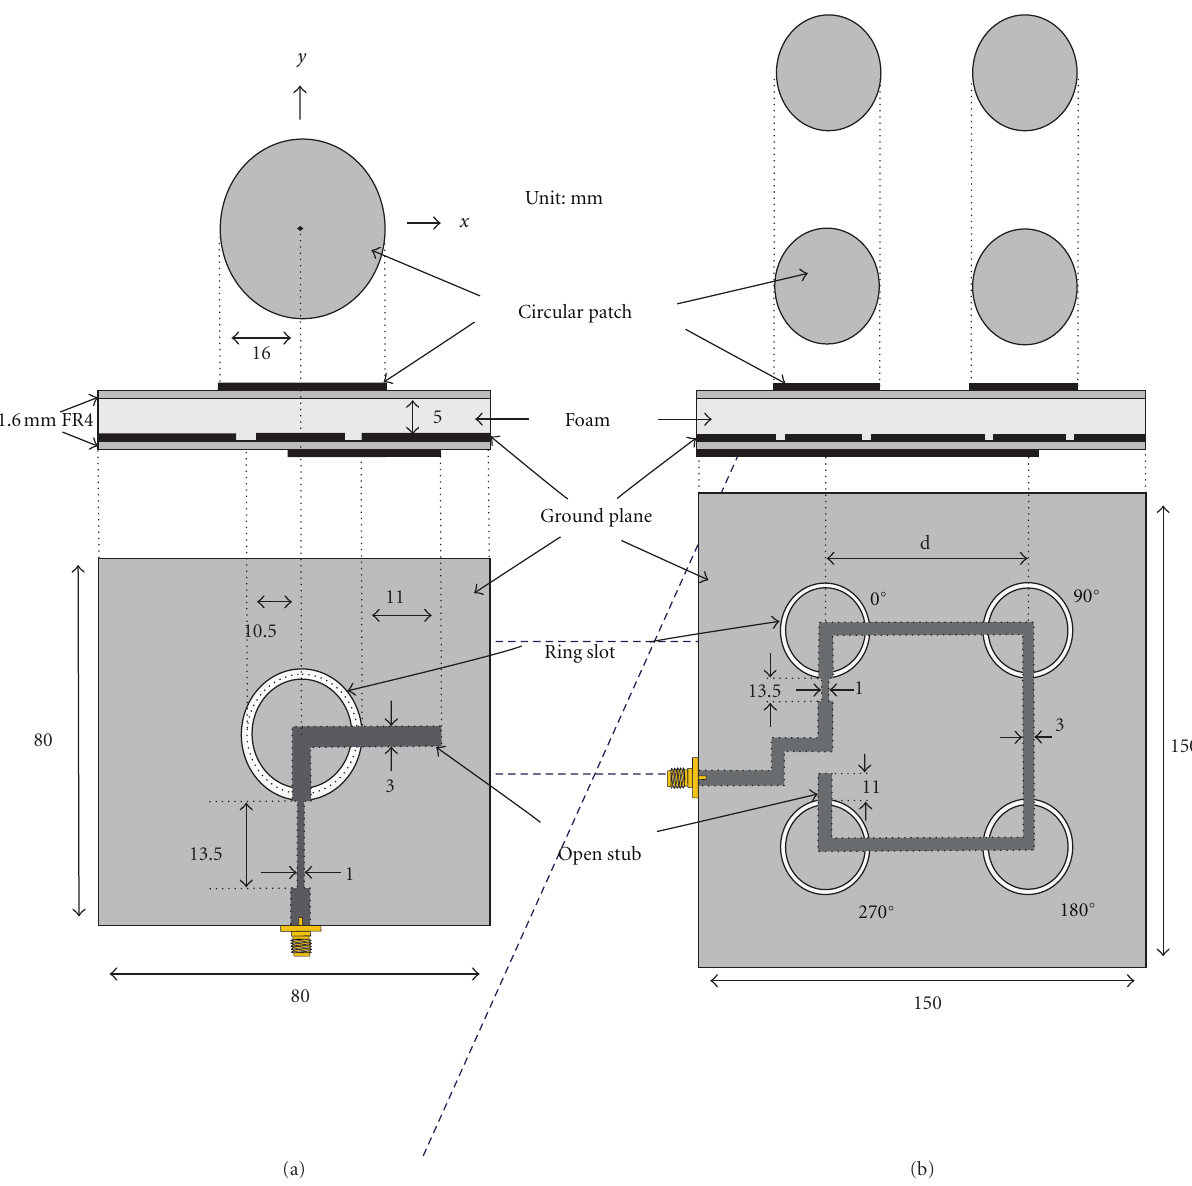
Figure 1: Geometry of the studied microstrip antennas. (a) Single ring-slot-coupled microstrip antenna. (b) 2 × 2 CP microstrip array